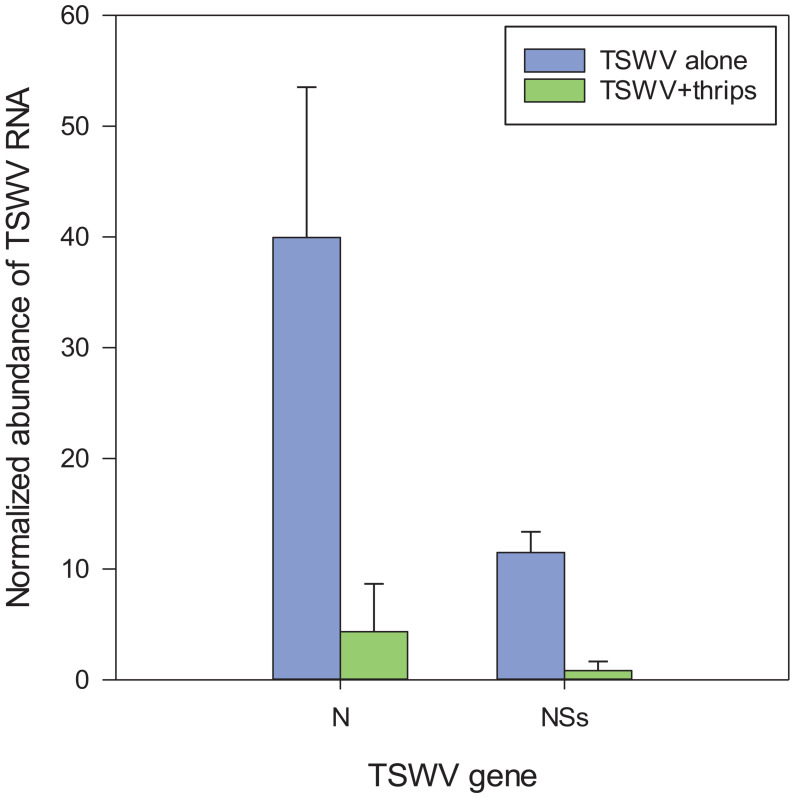
Estimation of virus titer in tomato plants systemically-infected with TSWV, 3-weeks post rub-inoculation. TSWV abundance was estimated by real-time quantitative reverse transcription PCR of TSWV N and NSs RNA normalized to tomato elongation factor 1 (leEF1) RNA in the 10th-youngest leaf of plants infected with TSWV alone (TSWV) or infested with F. occidentalis females (TSWV + thrips). Each bar represents the mean (and standard error) of three biological replications (n = 3 plants) of the thrips performance/microarray experiment. Analysis of variance revealed significant differences between the TSWV and TSWV + thrips treatments [N, P = 0.067; NSs, P = 0.006].